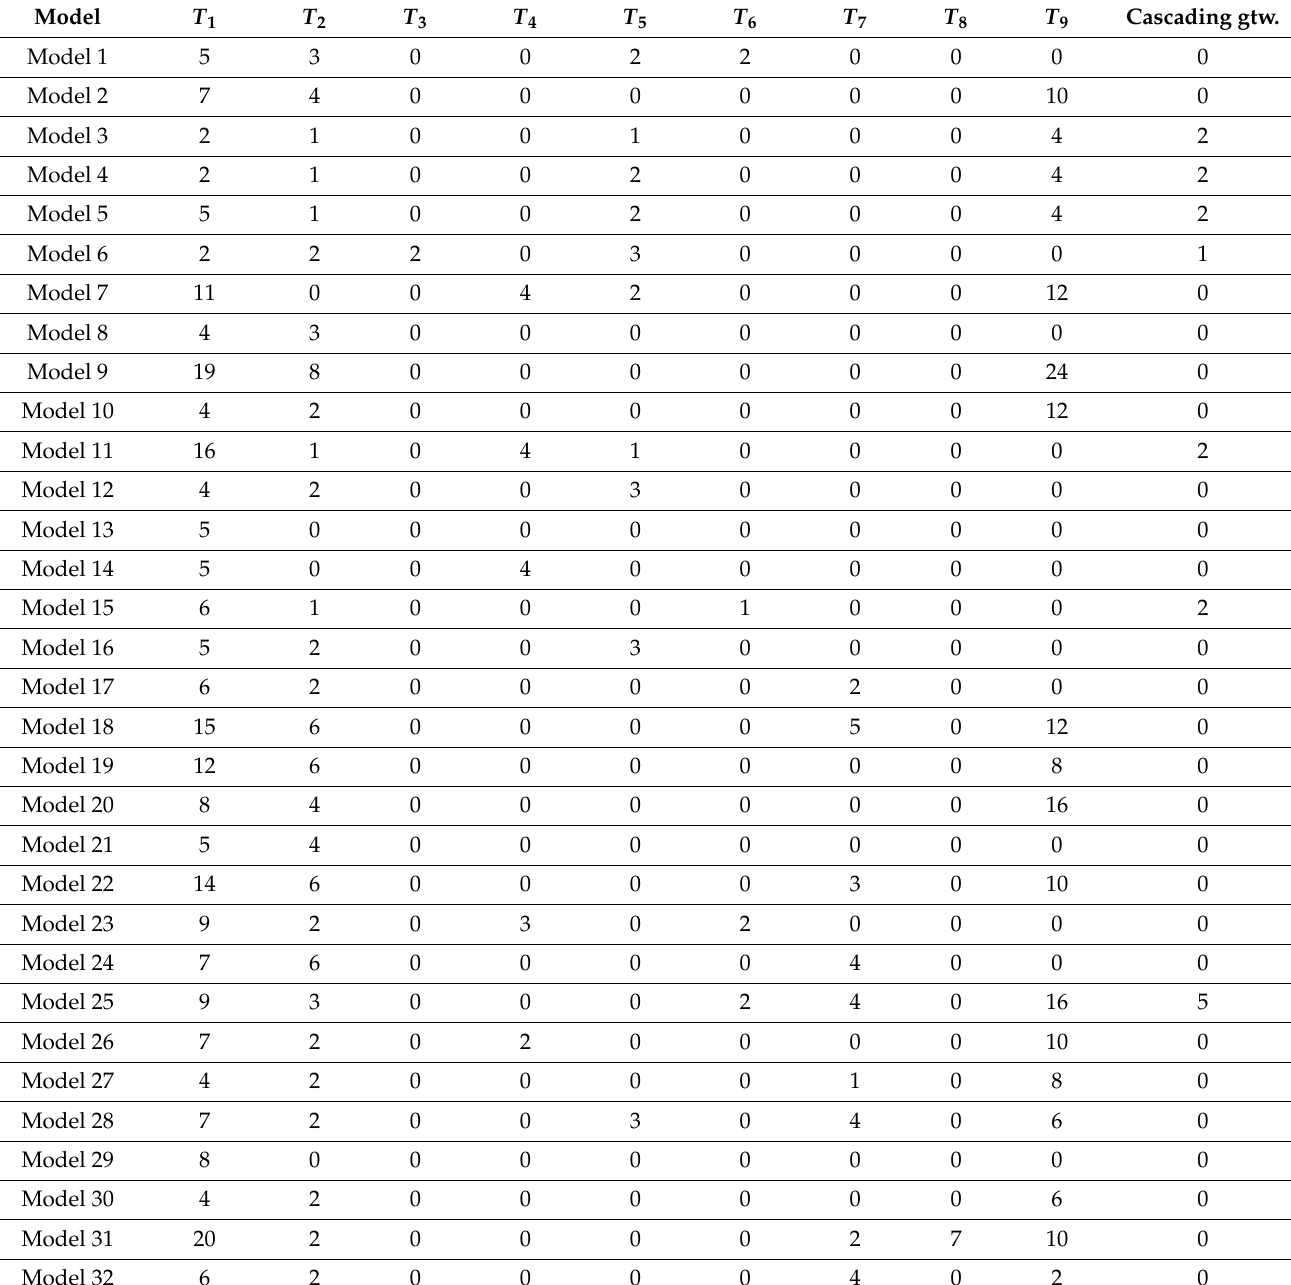
Table 4. Statistics of the automatically extracted process